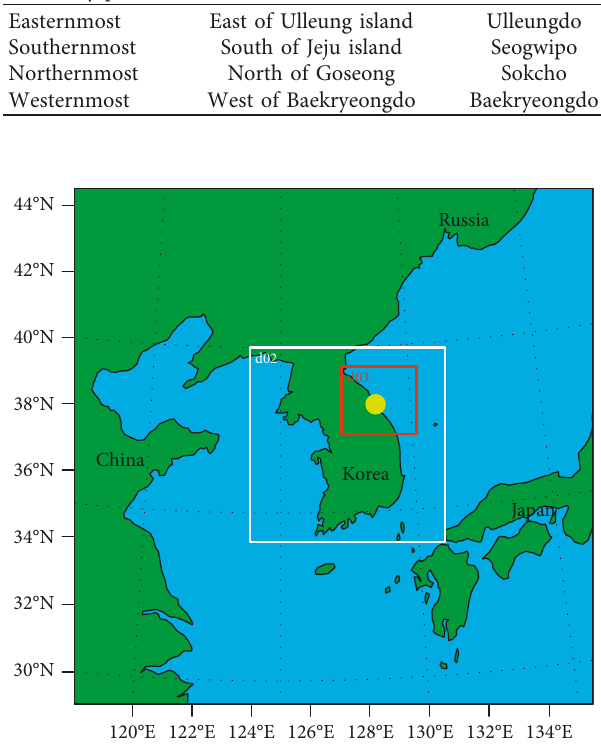
Figure 3: Nested WRF model domain over the Korean peninsula.